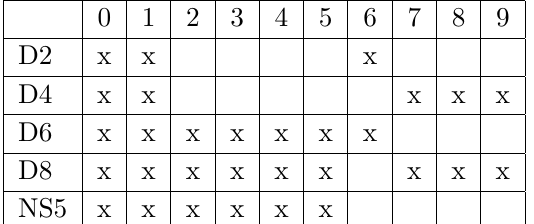
Figure 1 . Generic quiver (cid:12)eld theory whose IR is holographic dual to the solutions discussed in this section. The solid black line represents a (4,4) hypermultiplet, the grey line a (0,4) hypermultiplet and the dashed line a (0,2) Fermi multiplet. (4,4) vector multiplets are the degrees of freedom at each node.